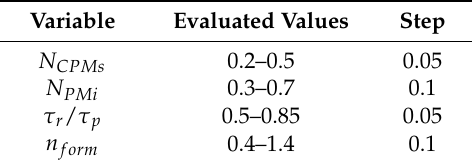
Table 1. Design variables evaluated for the case